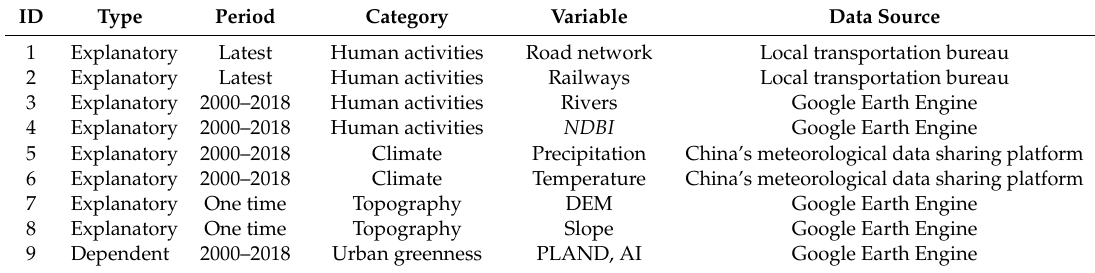
Table 1. Datasets used in the study. NDBI , normalized difference built-up index; DEM, digital elevation model; PLAND, percentage of landscape; AI, aggregation index.